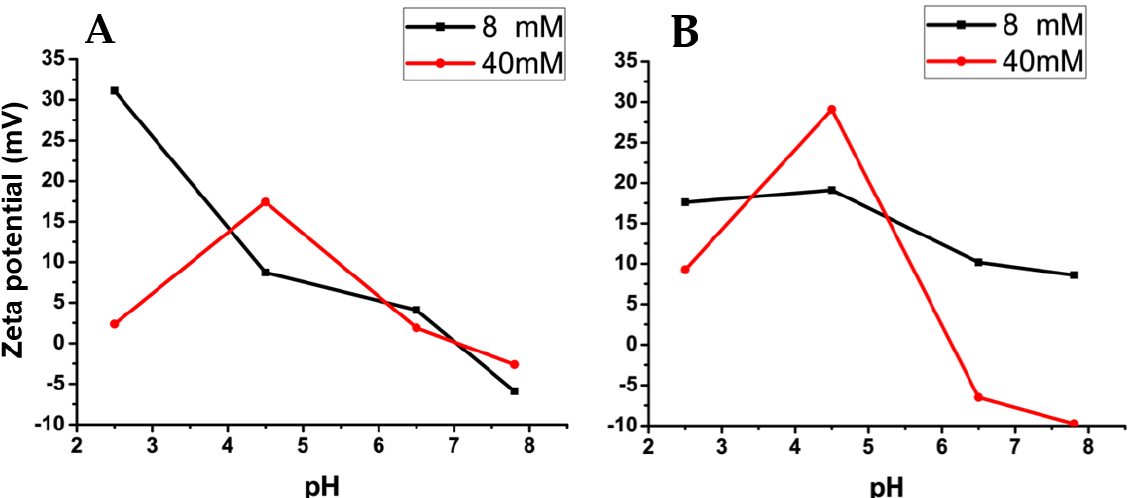
Figure 2. Variation of mean zeta potential as a function of pH in buffers of different concentrations as indicated. ( A ) Results of bioparticles containing JM72. ( B ) Results of bioparticles without JM72. Lines are guide to the eye.